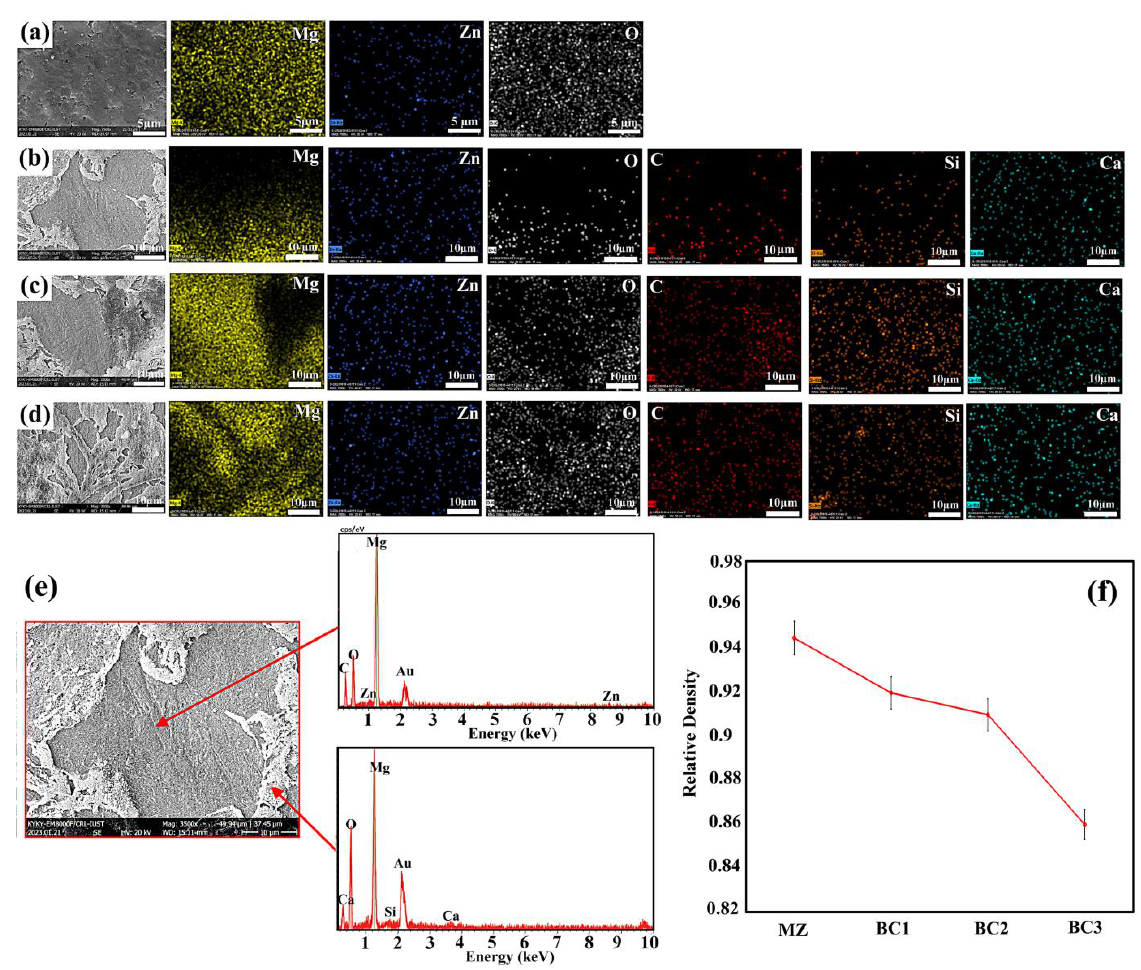
Figure 4. SEM and map images ( a ) MZ ×7000, ( b ) BC1 ×3500, ( c ) BC2 ×3500, ( d ) BC3 ×3500, ( e ) SEM and point EDS analysis of BC1 composite, ( f ) Relative density curve for samples after SPS process.